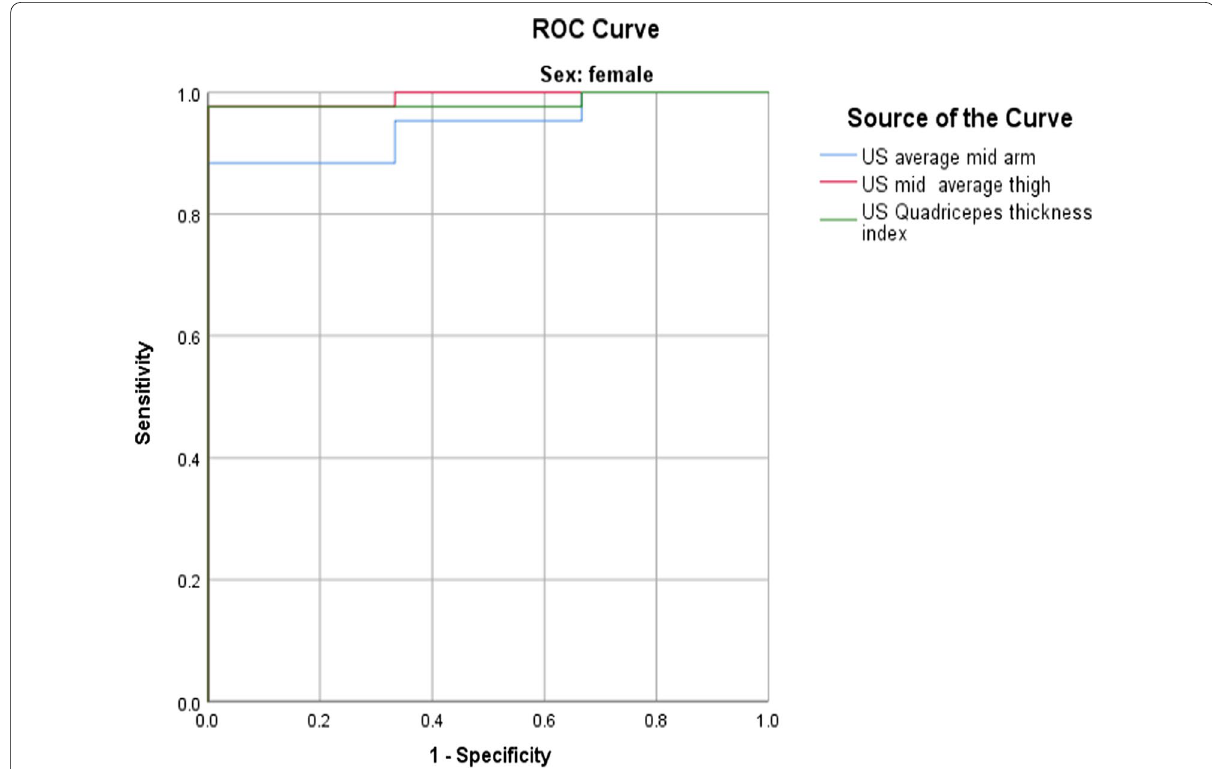
Fig. 10 Cut off value of female ultrasound muscle